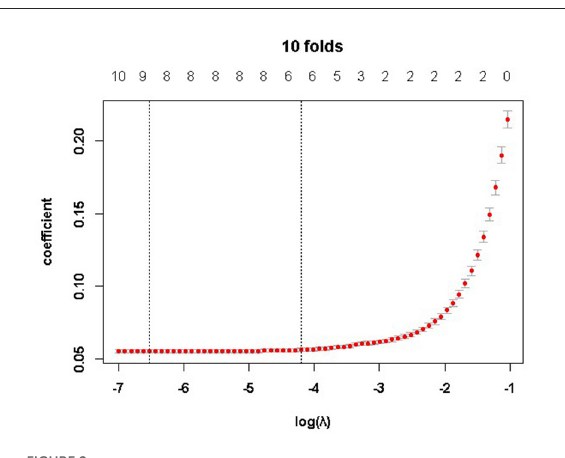
FIGURE2 Penalty parameter ( λ ) selection and model error.